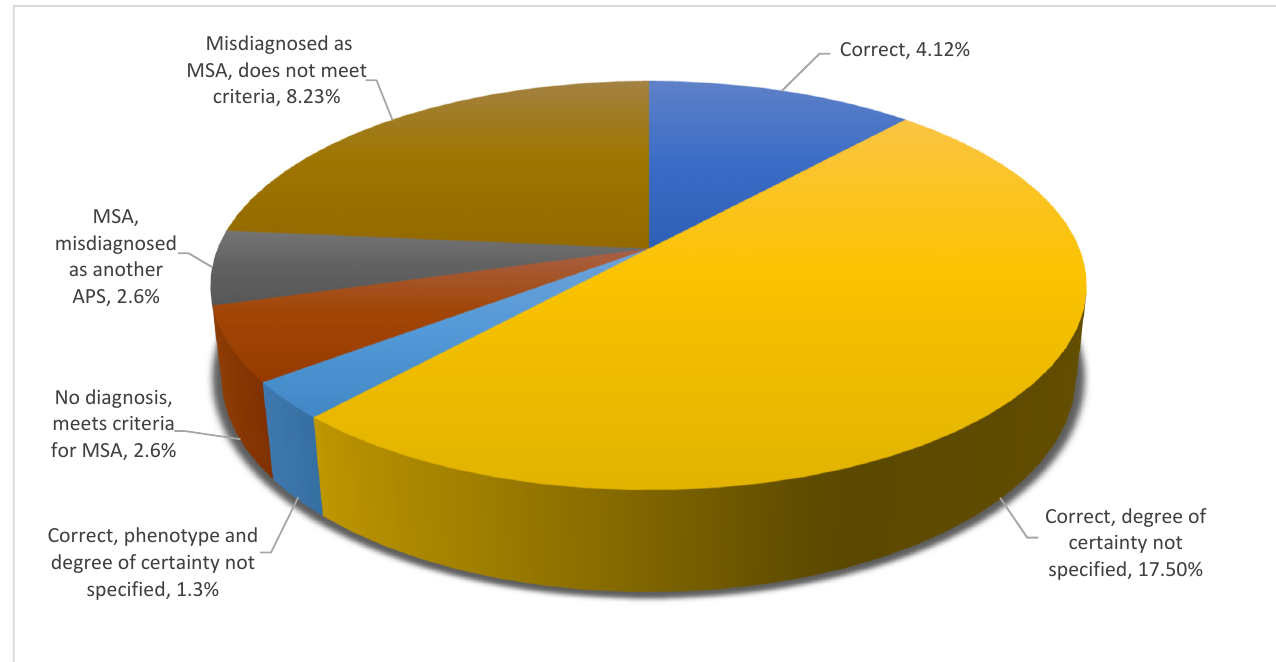
Figure 4. Distribution of diagnostic accuracy per degrees of precision.